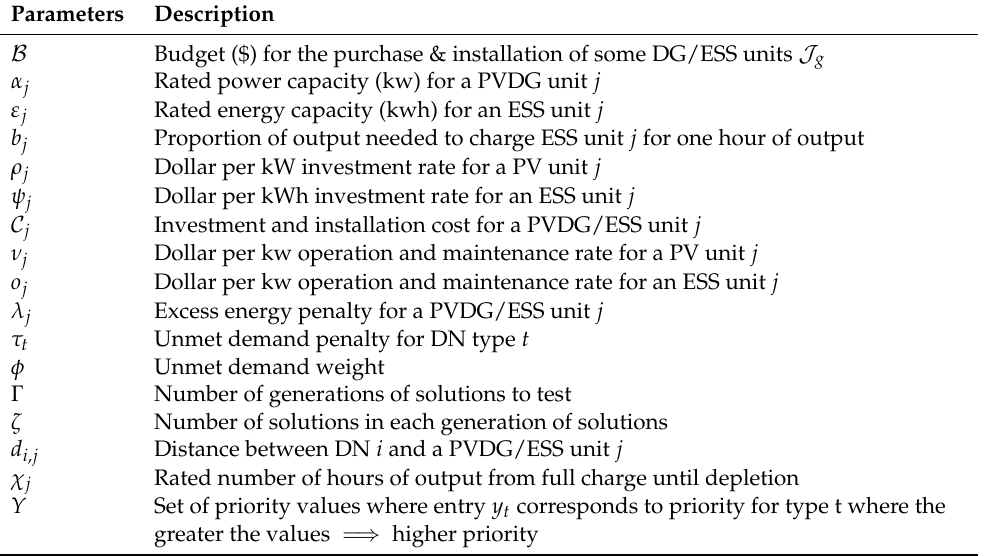
Table 2. Parameters used for MG model and optimization.